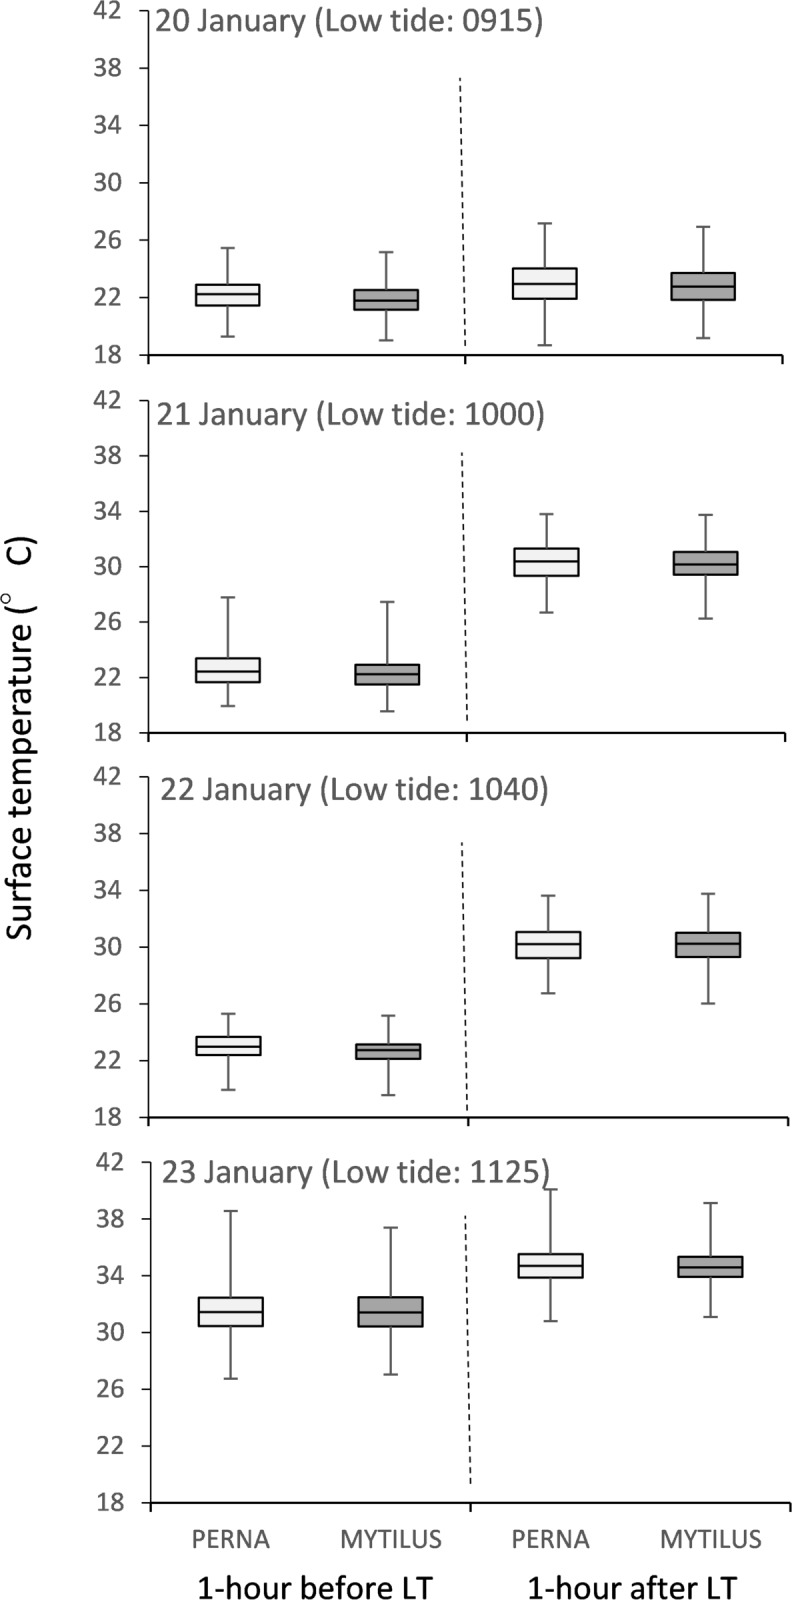
Small-scale temperature variability amongst individual mussels within the midshore region at Jongensfontein one hour before and one hour after low tide (LT) during four consecutive days in January 2015.Box plots represent median, interquartile range, maximum, and minimum. Sample sizes range from 250–290 individuals.